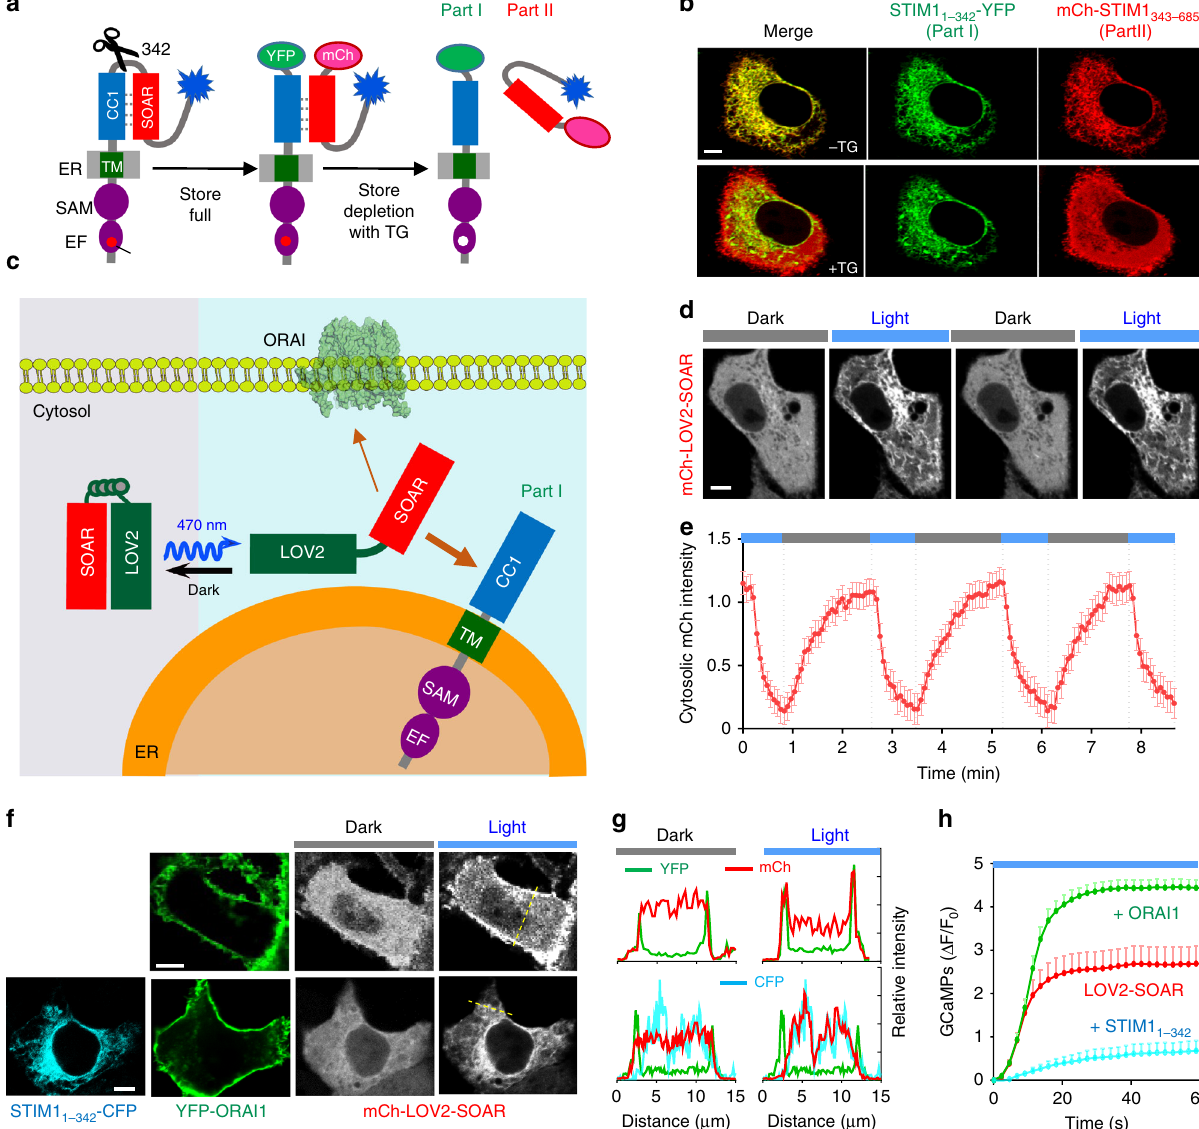
Fig. 2 An engineered LOV2-SOAR chimera to mimic STIM1ct autoinhibition mediated by CC1 – SOAR interaction. Data were shown as mean ± sem. Scale bar, 5 µ m. a Design of a split STIM1 molecule (at residue 342) to monitor CC1 – SOAR interaction in trans at real time. CC1 – SOAR maintains STIM1ct in an inactive con fi guration at rest. As a result, Part II (mCh-STIM1 342 – 685 ) tightly docks to the ER-resident Part I (STIM1 1 – 342 -YFP) when the store remains full. Upon store depletion, structural changes propagate toward the CC1 region to weaken its association with SOAR, thereby leading to the cytosolic dispersion of Part II as shown in panel b . b Confocal images showing the distribution of split STIM1 molecules (green, STIM1 1 – 342 -YFP; red, mCh-STIM1 343 – 685 ) before and after thapsigargin (TG)-induced store depletion in HeLa cells. c Schematic illustrating the design of a LOV2-SOAR (STIM1 336 – 486 ) chimera to mimic the CC1 – SOAR interaction that locks STIM1ct in an inactive state. CC1 is replaced by LOV2 (light-oxygen-voltage domain 2) to tightly cage SOAR in the dark. Upon blue light stimulation, the J α helix becomes disordered to uncage SOAR, thereby restoring its activity to engage and gate ORAI channels. If the ER-resident Part I (STIM1 1 – 342 -YFP) and PM-embedded ORAI1 are co-expressed, LOV2-SOAR can be used to determine the relative binding strength of SOAR toward ER-anchored CC1 or PM-resident ORAI1 channels. d Light-inducible cytosol-to-ER translocation of mCh-LOV2-SOAR in HEK293 cells co- transfected with Part I as shown in panel c . e Quanti fi cation of cytosolic mCherry signals (images in panel d ) following three repeated light-dark cycles ( n = 18 cells). f – h Comparison of the relative strength of SOAR-CC1 and SOAR-ORAI1 interactions. f Top: Light-induced cytosol-to-PM translocation of mCh-LOV2-SOAR (gray) observed in HEK293 cells co-transfected with YFP-ORAI1 (green). Bottom: Confocal images of HEK293 cells co-expressing mCh- LOV2-SOAR (gray), YFP-ORAI (green) and STIM1 1 – 342 -CFP (cyan). In the dark, mCh-LOV2-SOAR was evenly distributed in the cytosol. Upon photostimulation, mCh-LOV2-SOAR preferred to translocate toward ER membrane but not to PM. g The fl uorescence intensities (YFP, green; mCh, red; CFP, cyan) across the dashed line were plotted to evaluate the degree of colocalization. h Light-induced Ca 2 + response curves (quanti fi ed by GCaMP6s) in HEK293 cells transfected with LOV2-SOAR (red), LOV2-SOAR + ORAI1 (green) or LOV2-SOAR + Part I (STIM1 1 – 342 ; blue). n = 30